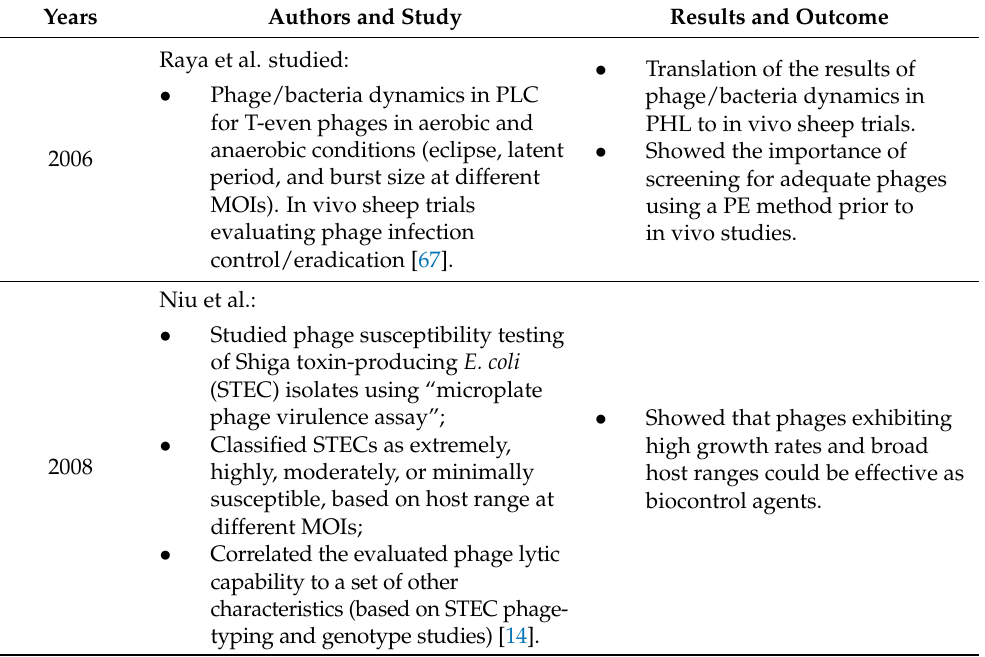
Table 1. PLC experiments and translation of the